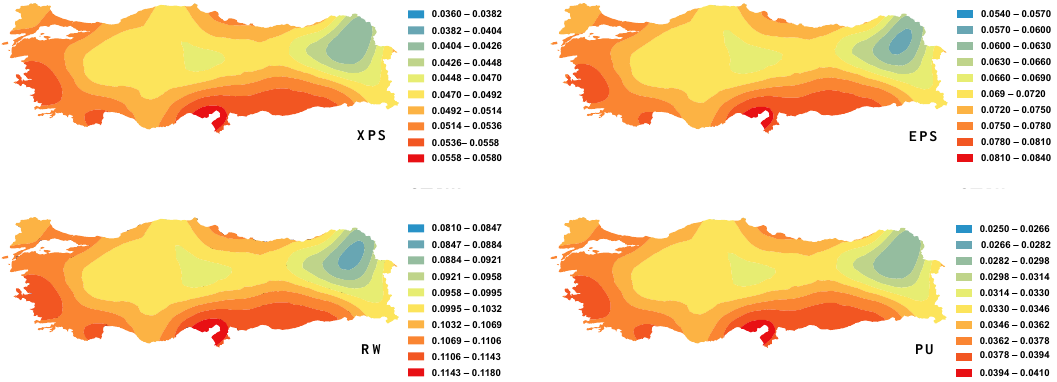
Figure 5. Spatial maps of the optimum insulation thickness in all climate zones of Türkiye at − 20 ◦ C reference temperature for four insulation materials (each of the maps has its own legend).